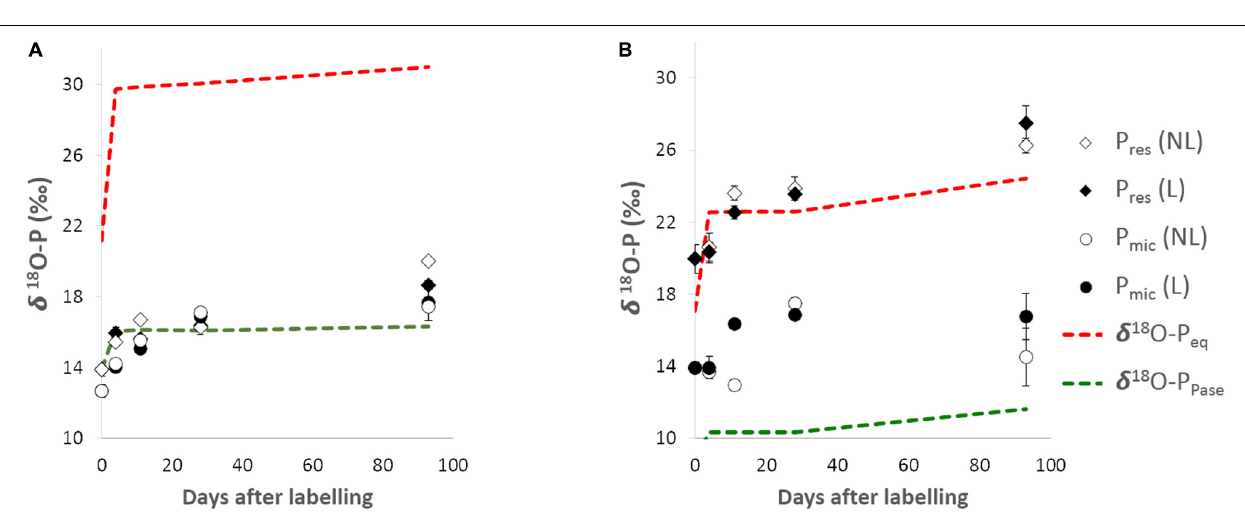
FIGURE 1 | CO 2 emitted from Lüss (LUE; A ) and Bad Brückenau (BBR; B ) soils during the incubation. Gray circles indicate respiration rates during the pre-incubation period, white circles the respiration rates in the non-amended treatment (NL) and black circles in the leaf-litter amended treatment (L). Error bars indicate replicates standard